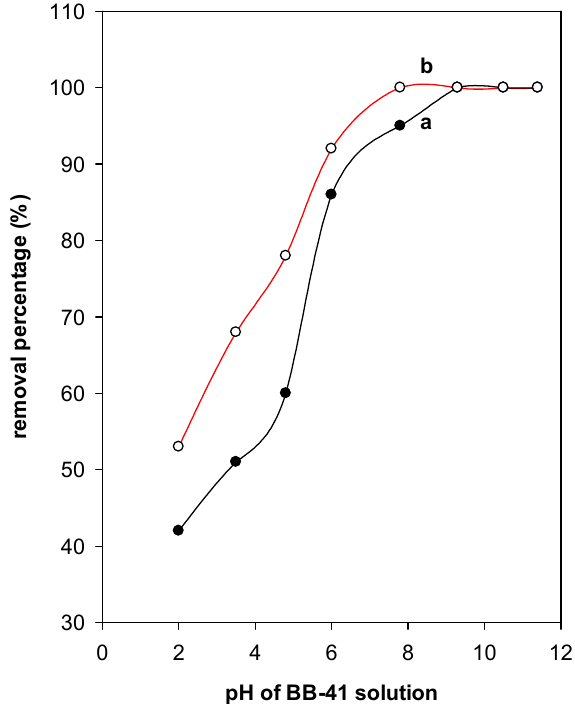
Figure 9. Effect of pH on the removal percentage (%) of ( a ) Al-PCH and ( b ) Zr-PCH materials.